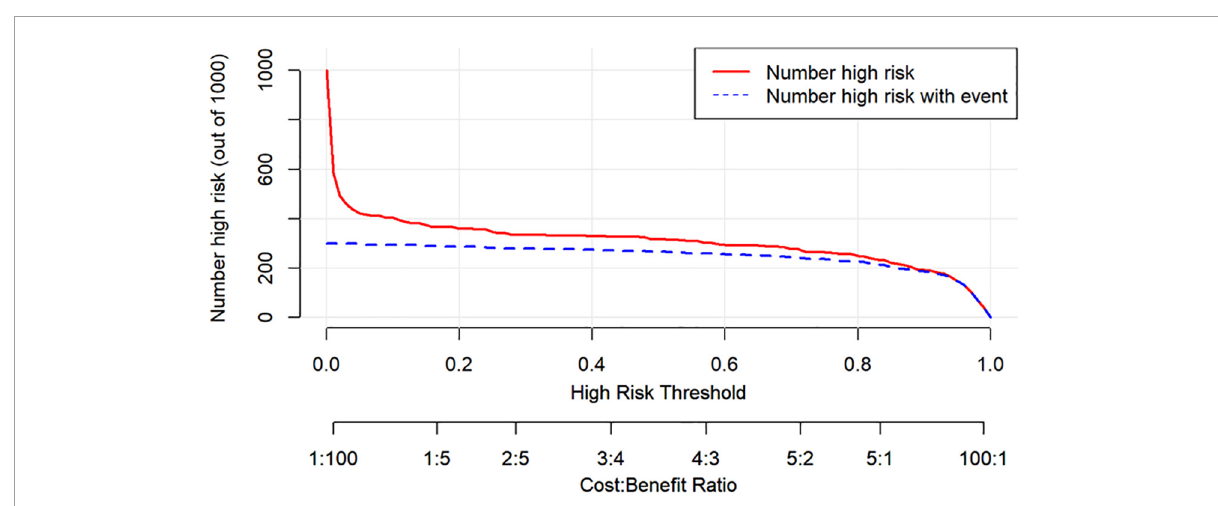
FIGURE8 The clinical impact curves of the nomogram model.